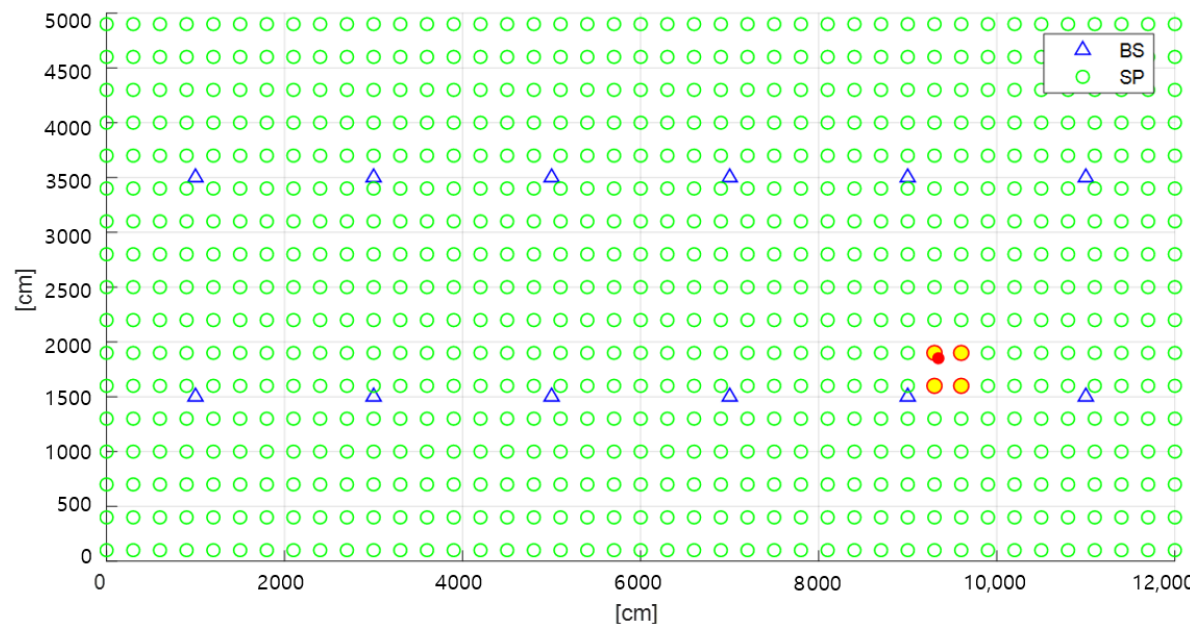
Figure 6. Result of four SPs by WFM.